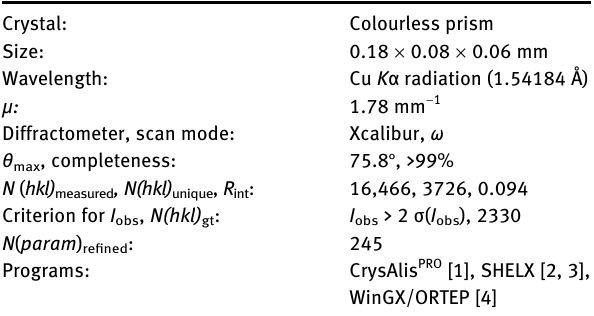
Table  : Data collection and